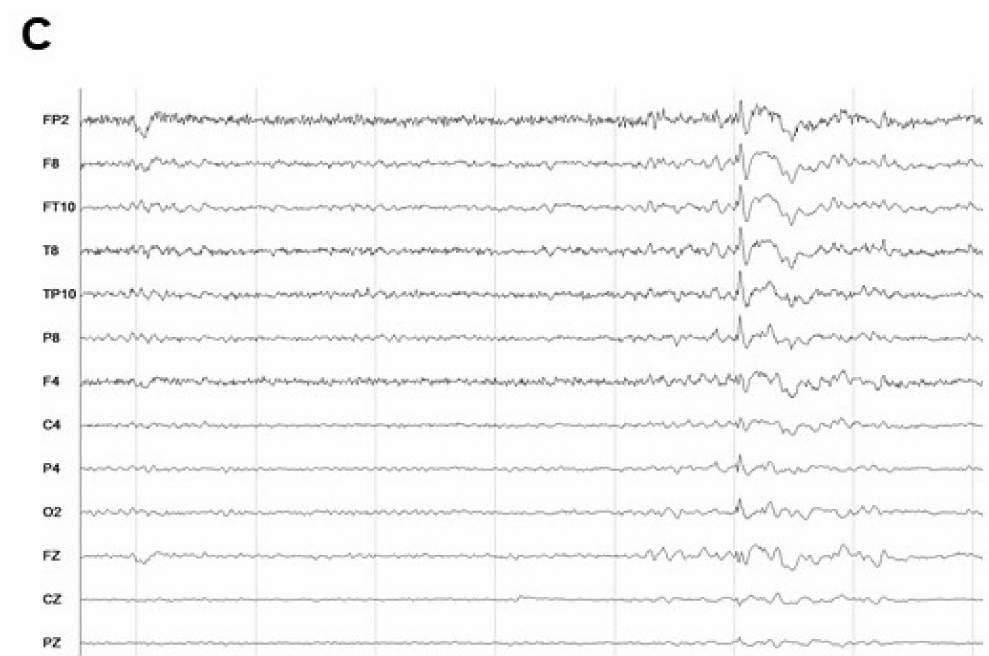
Figure 1. The patient presents with cerebellar atrophy and epilepsy. ( A ) Brain MRI section showing marked atrophy of the cerebellar vermis (T1-weighted image). ( B ) Brain MRI section showing slight atrophy of the cerebellar hemispheres (T2-weighted image). ( C ) Interictal EEG showing a frontotemporal spike, most prominent in the temporal leads (FT10, T8,